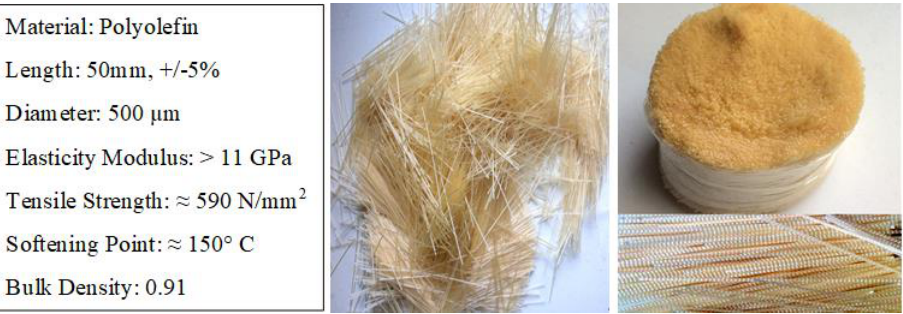
Table 1. Mixing proportion of concrete.